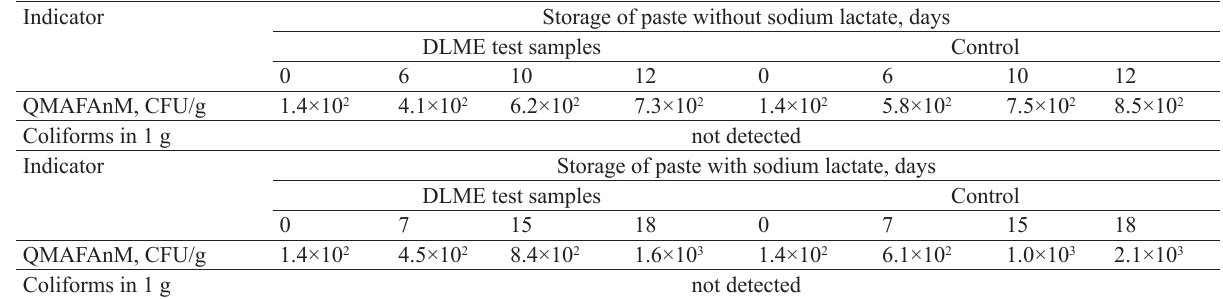
Table 5 Microbiological indicators of control and test samples during storage Indicator Storage of paste without sodium lactate, days DLME test samples